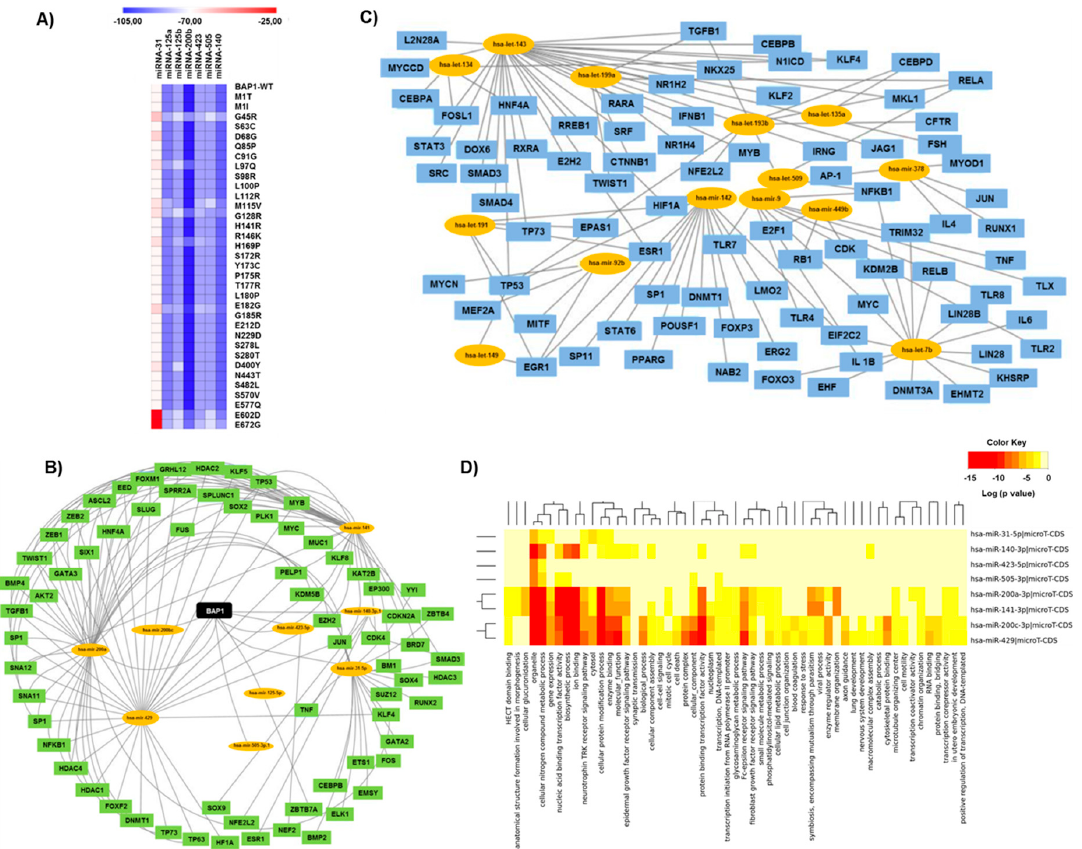
Figure 3. BAP1-miRNAs and associated gene regulatory network. ( A ) Heatmap showing fold change values of minimum free binding energy (mfe) intensity for BAP1 variants and the miRNAs (units: kcal/mol). ( B ) Local gene regulatory network associated with BAP1 and miRNAs. ( C ) Global gene regulatory network associated with miRNAs known to be altered in UM. ( D ) Gene ontology terms associated with BAP1-miRNAs.